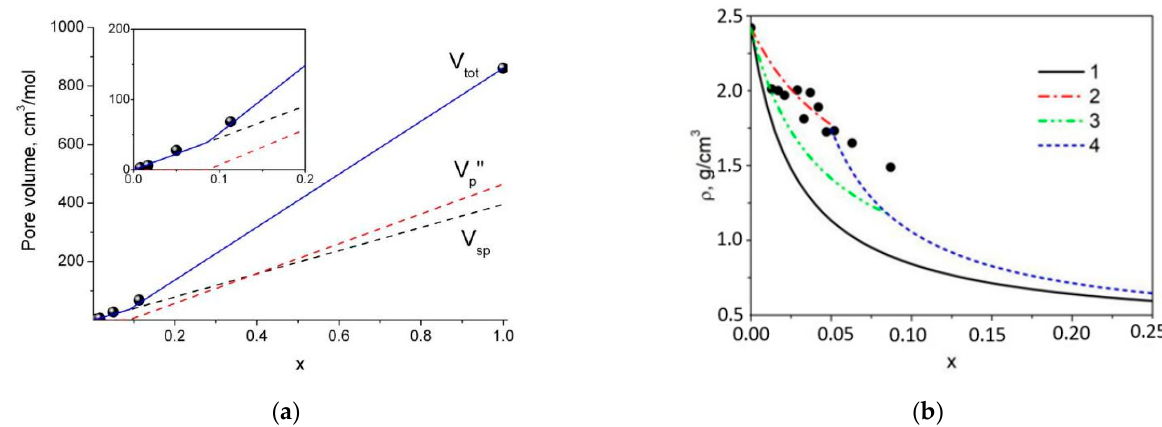
Figure 5. ( a ) Experimental values of the MIL-101(Cr) pore volume (symbols) in comparison with theoretical dependences obtained from Equations (8)–(10) for the total volume of unfilled pores ( V tot ), solid line, and values of V p ′′ and V sp (dash lines). The dependences were obtained at V 10 = 44 cm 3 /mol; V p 0 = 474 cm 3 /mol; V sp 0 = 387 cm 3 /mol. ( b ) Experimental values of density of the composite pellets (points) in comparison with theoretical dependences obtained using Equation (2) for a mixture of non-porous components (curve 1). Curves 2 and 3 were obtained for x < x max from Equation (13) at V p 0 = 861 cm 3 /mol and V p 0 = 474 cm 3 /mol, respectively; curve 4 was obtained from Equation (14) for x > x max . In all the cases V c 0 + V sp 0 + V p = 1553 cm 3 /mol.